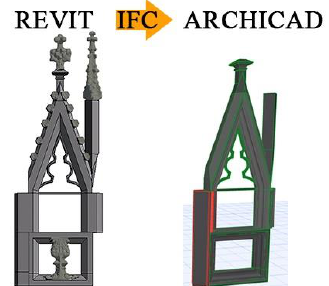
Figure 12. The complete IFC model, from Revit to Archicad. From Revit to Archicad: IFC